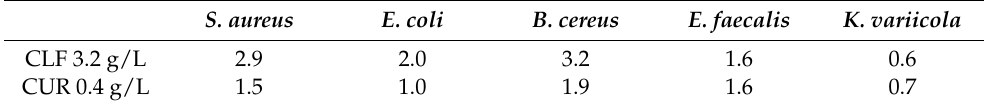
Table 1. Antibacterial activity (R) values obtained for each bacterial specie after contact with CLF or CUR paint samples.